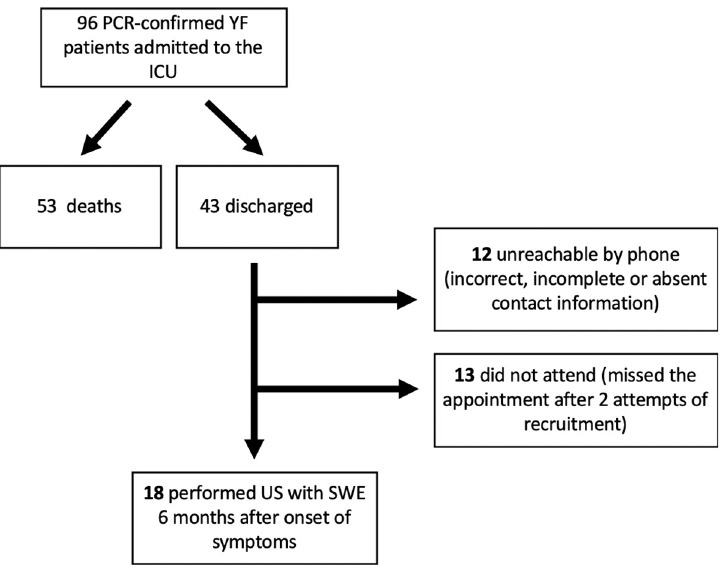
Fig 1. Flow diagram of patient enrolment. Of the 43 patients who survived severe yellow fever and were discharged, we managed to evaluate 18 patients with ultrasound elastography after 6 months of symptoms onset. Reasons for the losses of follow-up are specified on the right. PCR = Polymerase chain reaction. YF = Yellow fever. ICU = Intensive care unit. US = Ultrasound. SWE = Shear-wave elastography.